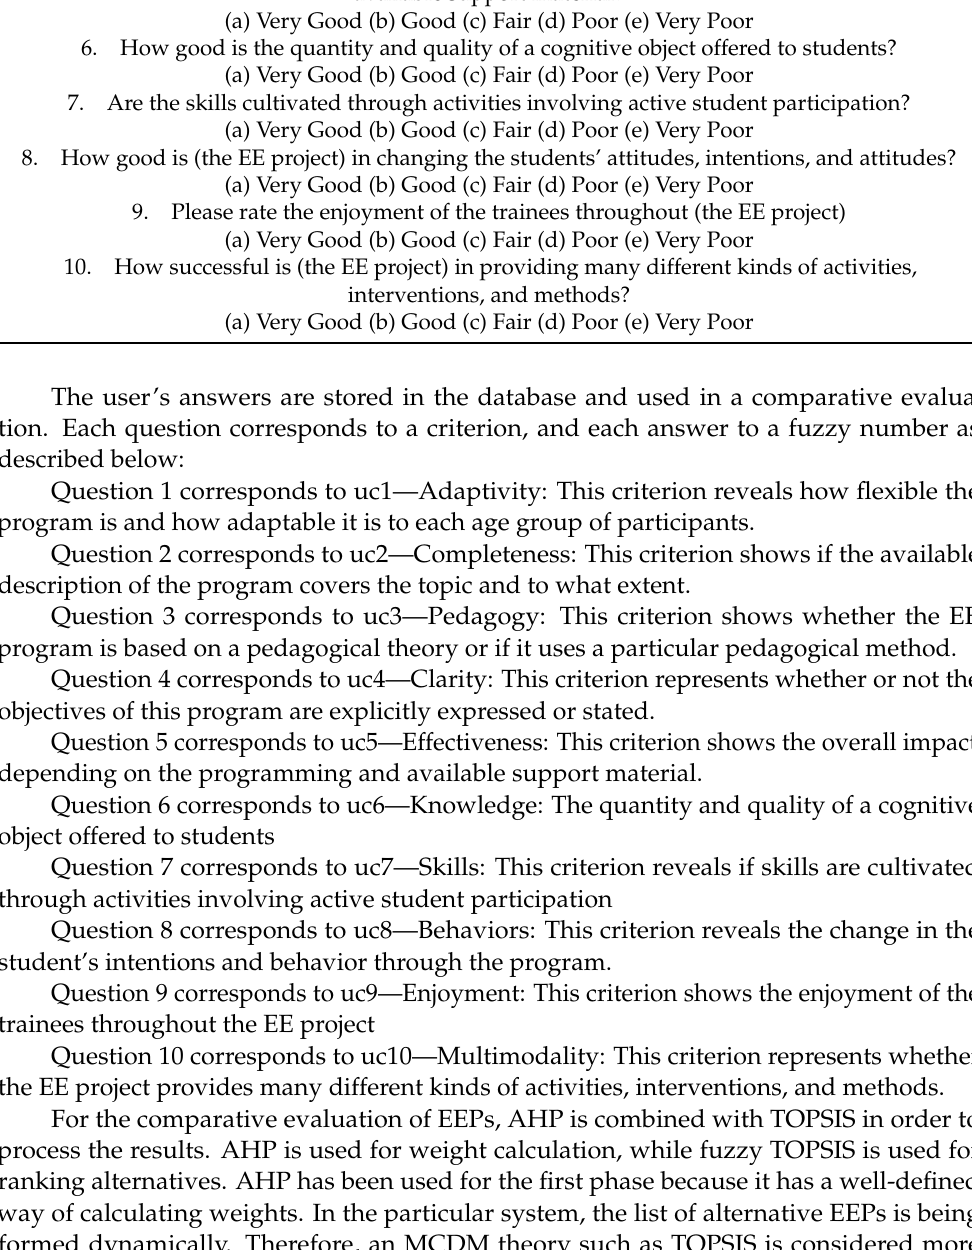
Comparative Evaluation